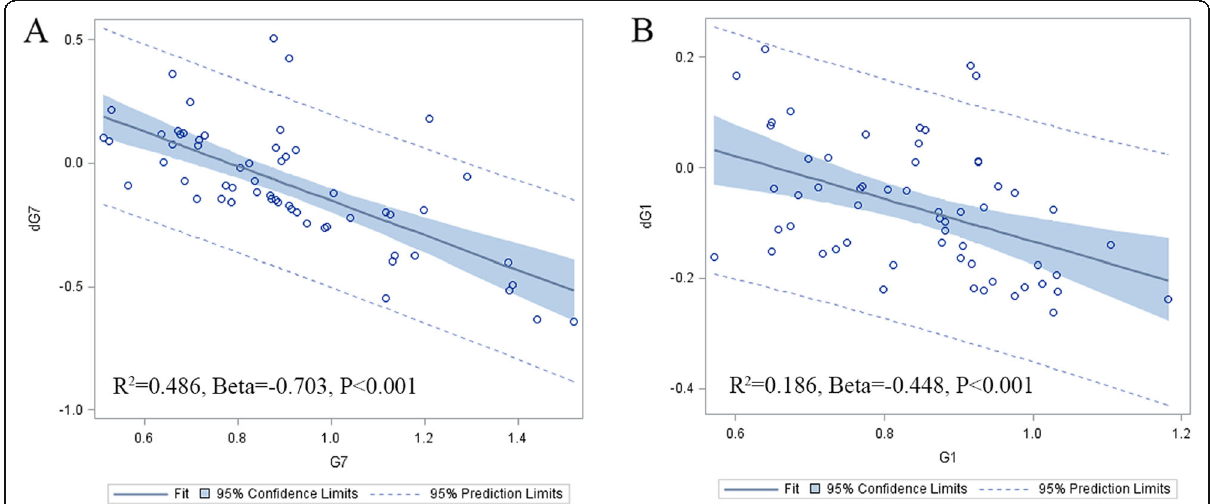
Fig. 5 The BMD of Gruen zone 7 ( a ) and 1 ( b ) measured 1 week after surgery were also analyzed for the value as a predictor for BMD changes of Gruen zone 7 and 1 in the first postoperative year by using a multiple linear model with the calculation of the coefficients of determination (R 2 ), respectively. Other variables enrolled in the multiple linear analysis included sex, age, BMI, primary diagnosis, and preoperative BMD of